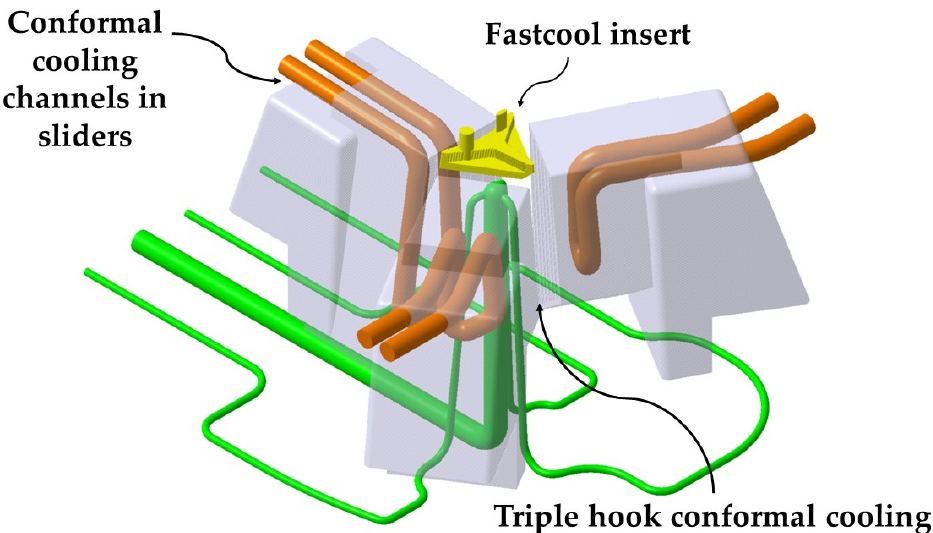
Figure 7. Conformal cooling of the core and sliders of the mold.